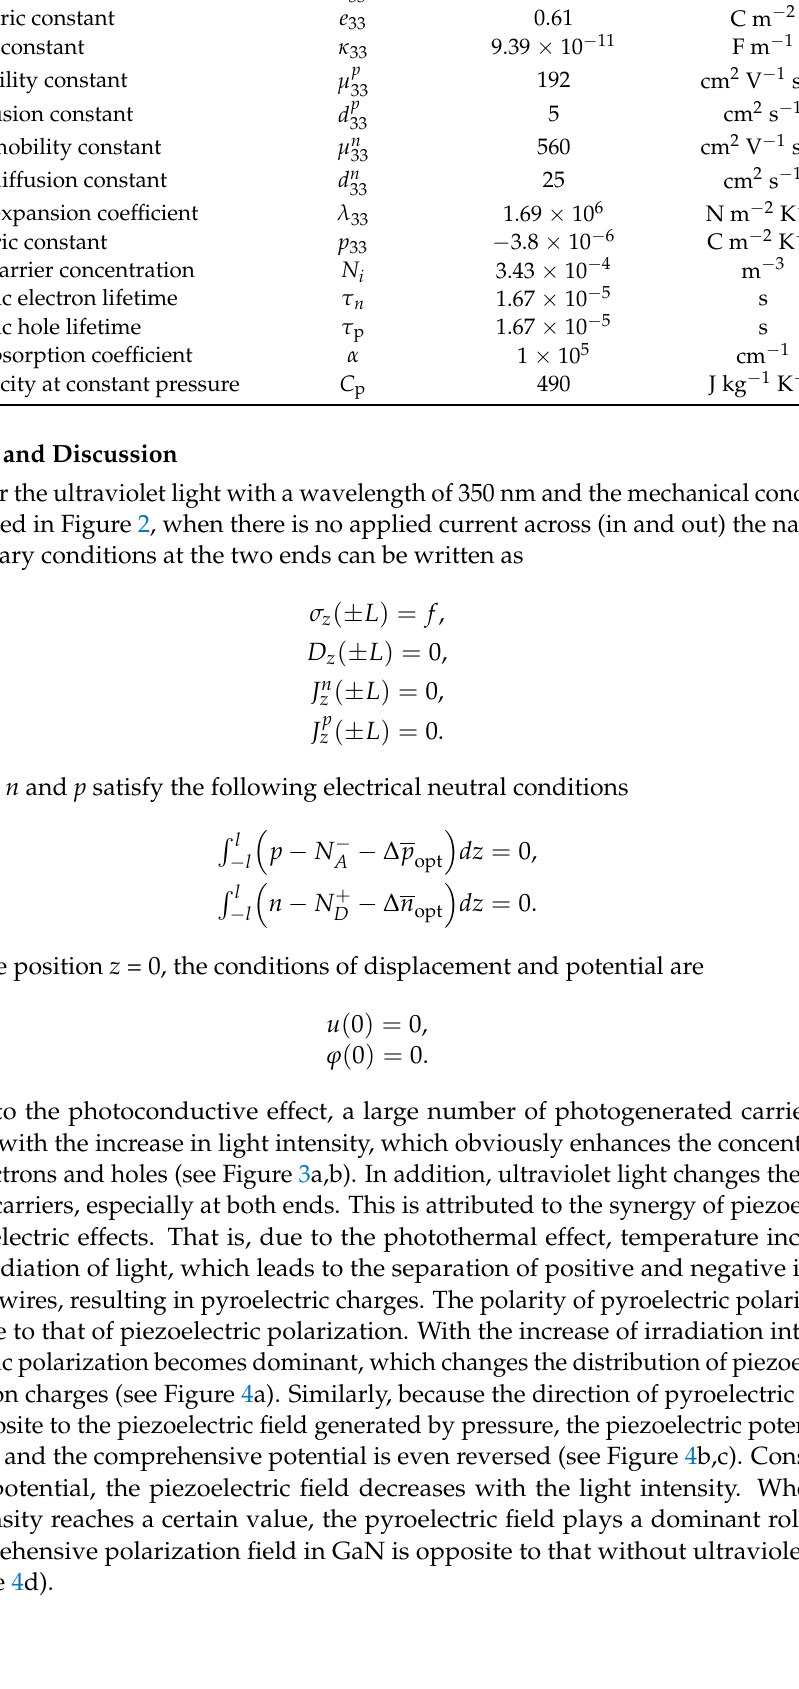
Table 1. Material constants used in the analysis of a GaN nanowire. Property Parameter Value Unit Elastic constant c 33 289.2 GPa Piezoelectric constant e 33 0.61 C m − 2 Dielectric constant κ 33 9.39 × 10 − 11 F m − 1 Hole mobility constant µ p 192 cm 2 V − 1 s − 1 33 Hole diffusion constant d p 5 cm 2 s − 1 33 Electron mobility constant µ n 560 cm 2 V − 1 s − 1 33 Electron diffusion constant d n 25 cm 2 s − 1 33 Thermal expansion coefficient λ 33 1.69 × 10 6 N m − 2 K − 1 Pyroelectric constant p 33 − 3.8 × 10 − 6 Intrinsic carrier concentration N i 3.43 × 10 − 4 m − 3 Photogenic electron lifetime τ n τ